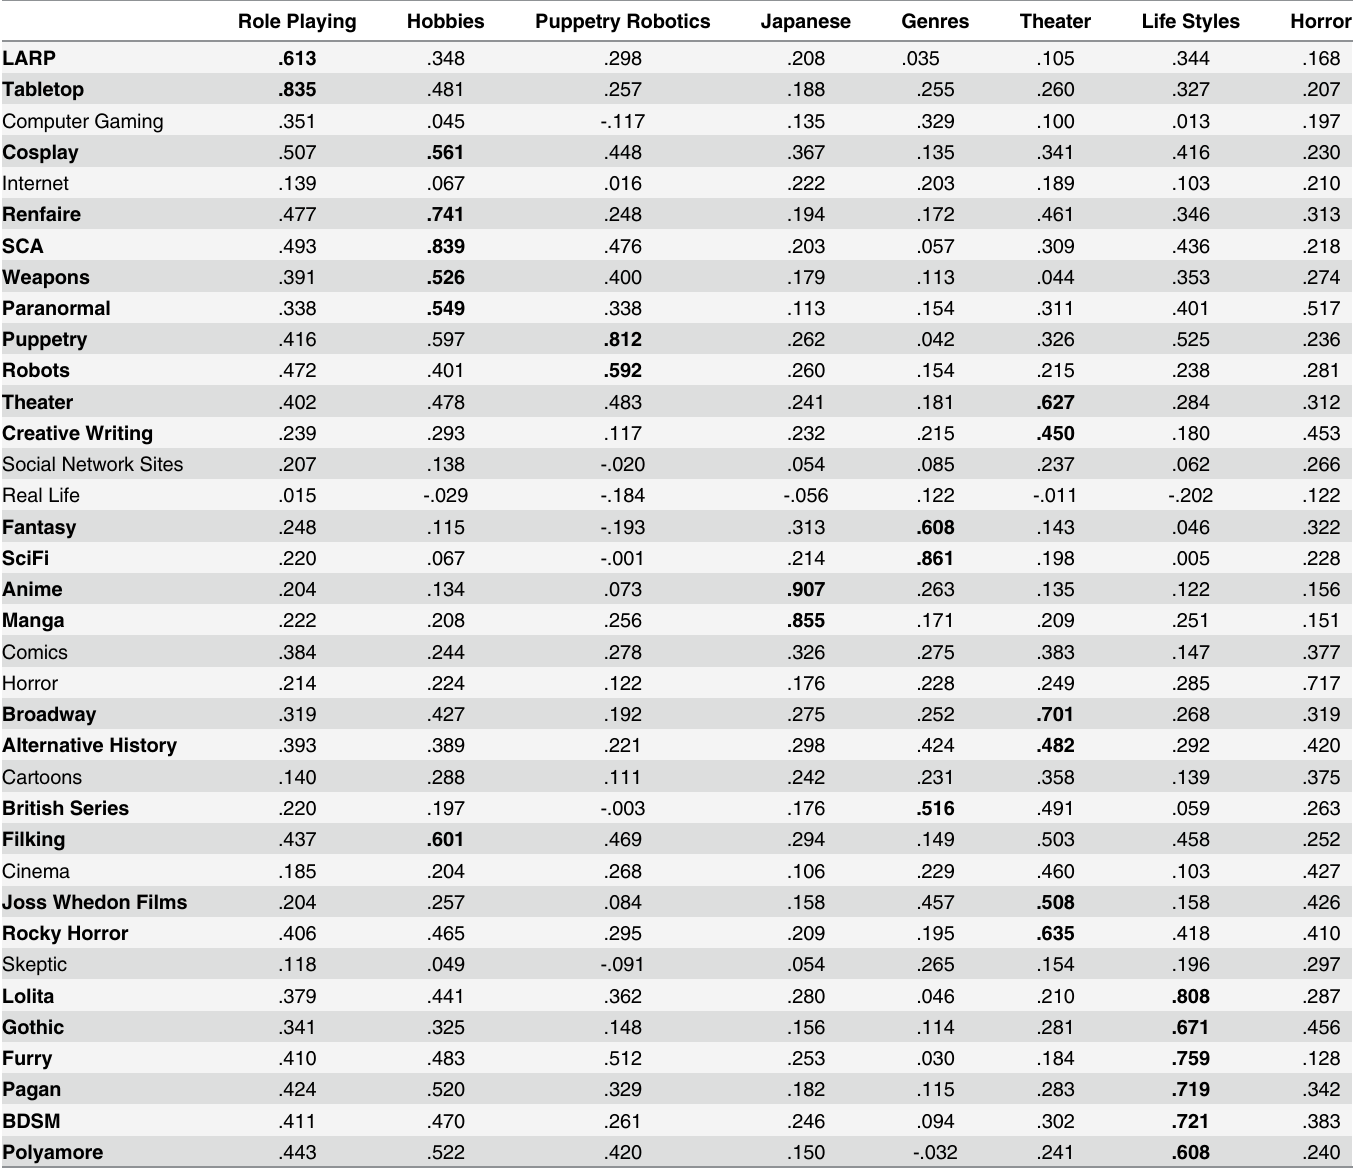
Table 2. Exploratory Factor Analysis of Geek